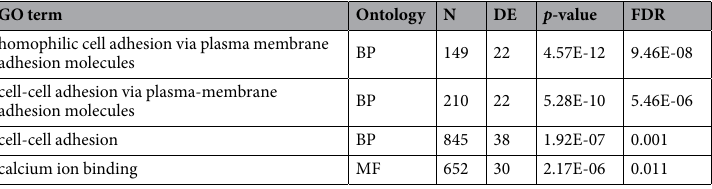
Table 4. Significantly enriched GO terms (FDR < 0.05) for the CpGs with p -value < 0.0001 from the female- only analysis. N, number of genes represented by a GO term; DE, number of genes from the GO term that were included in the CpGs with p < 0.0001; FDR, FDR-adjusted p -value for enrichment; BP, biological process; MF, molecular